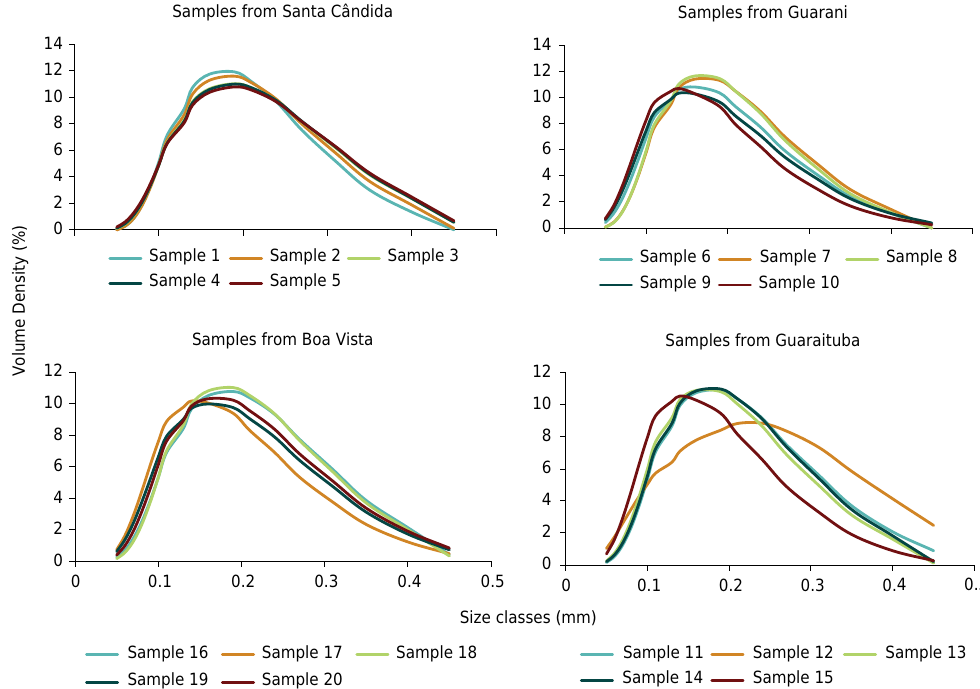
Figure 5. Frequency of distribution according to the size-classes of the sand fraction, obtained by PSD. Note: a complete identification of the samples is presented in table